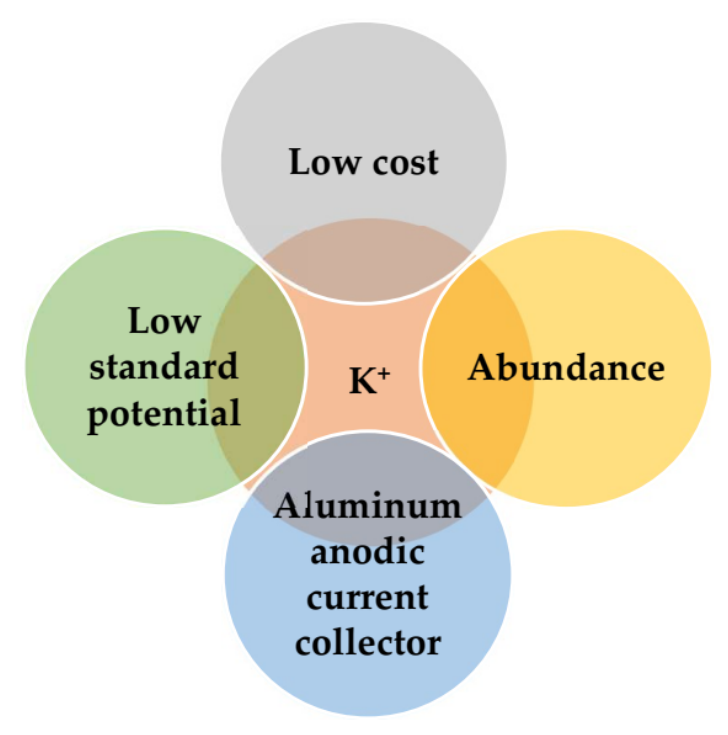
Figure 2. Some advantages of K + for their implementation in rechargeable K-ion